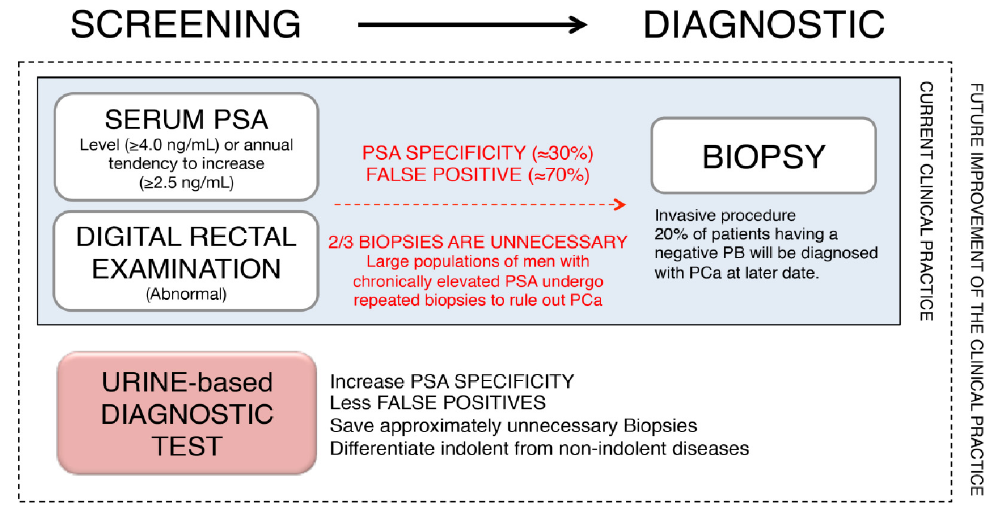
Figure 2. Current and future improvement in the PCa diagnostic